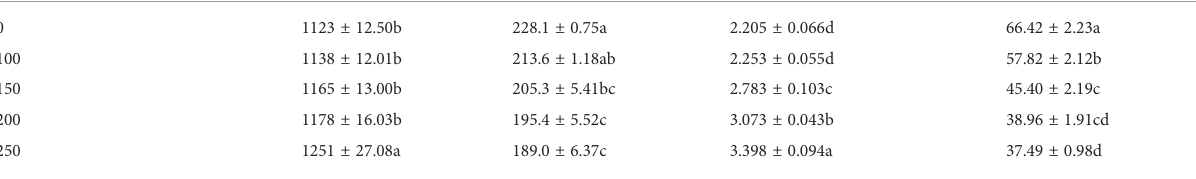
TABLE 2 Antioxidant enzyme activity and soluble protein content of Nasturtium of fi cinale .